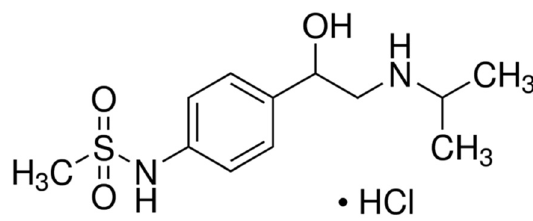
Figure 1: Structural formula of